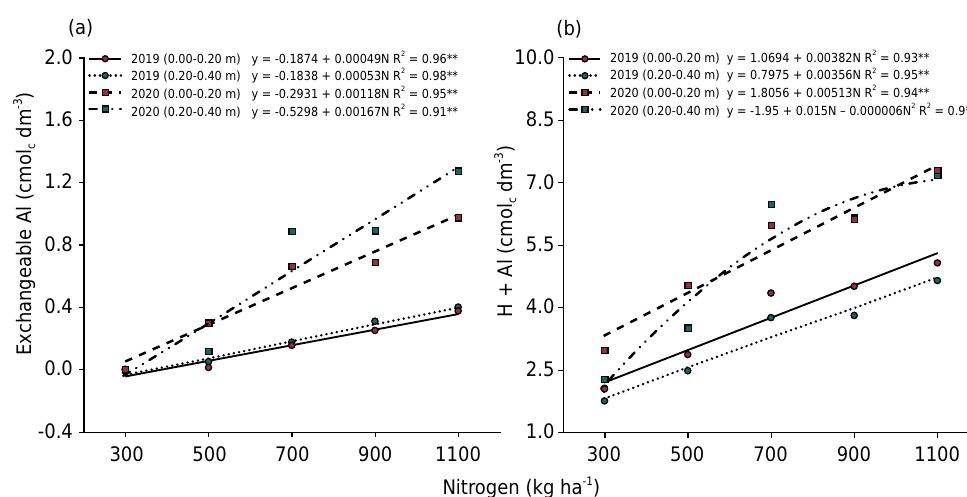
Figure 3. Exchangeable Al values (a) and H+Al (b) at layers of 0.00-0.20 and 0.20-0.40 m in the soil cultivated with Conilon coffee, in response to the application of nitrogen doses. * and **: significant at 5 and 1 % probability,